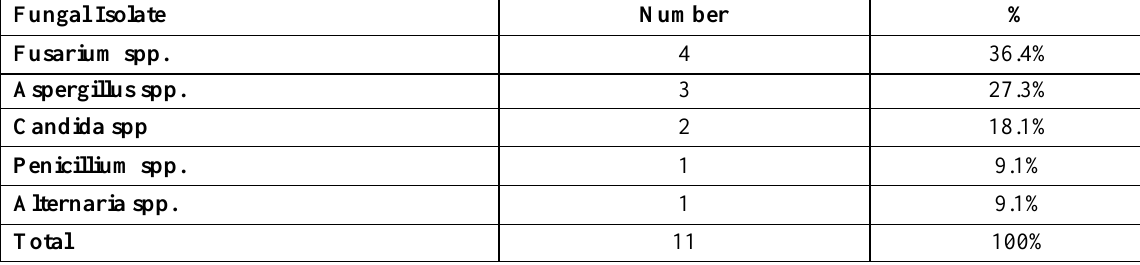
Table 6. Distribution of bacterial isolates among corneal ulcer cases. Bacterial Isolate Staphylococcus aureus Staphylococcus Coagulase Negative Pseudomonas spp.